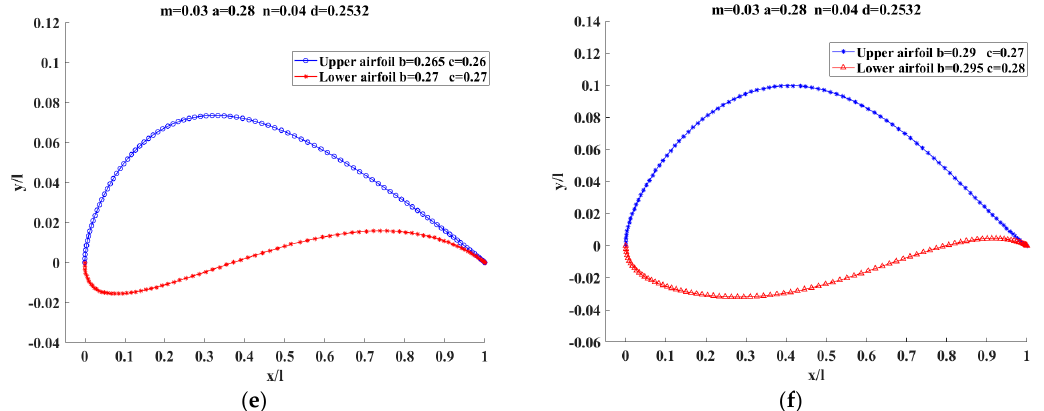
Figure 8. Influence of parameter changes on airfoil shape. ( a ) b = 0.265~0.275 c = 0.26~0.28; ( b ) b = 0.285~0.295 c = 0.26~0.28; ( c ) b = 0.265~0.275 c = 0.23~0.25; ( d ) b = 0.285~0.295 c = 0.23~0.25; ( e ) b = 0.265~0.27 c = 0.26~0.27; ( f ) b = 0.29~0.295 c = 0.27~0.28.